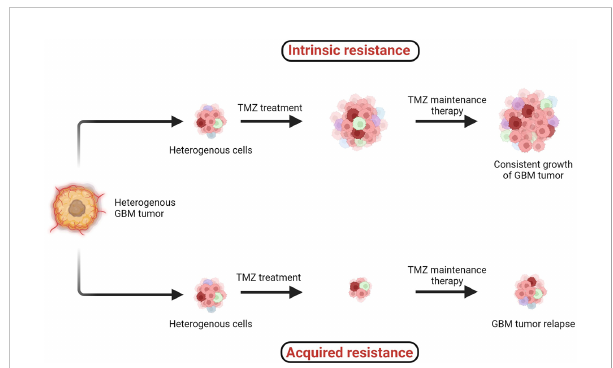
FIGURE 4 Two major types of resistance development: (1) intrinsic and (2) acquired resistance. Intrinsic resistant tumors contain very small amounts of or no antitumor T cells, creating natural resistance against therapies. Acquired resistance is resistance development against the therapy after clinical treatments are given (38 –